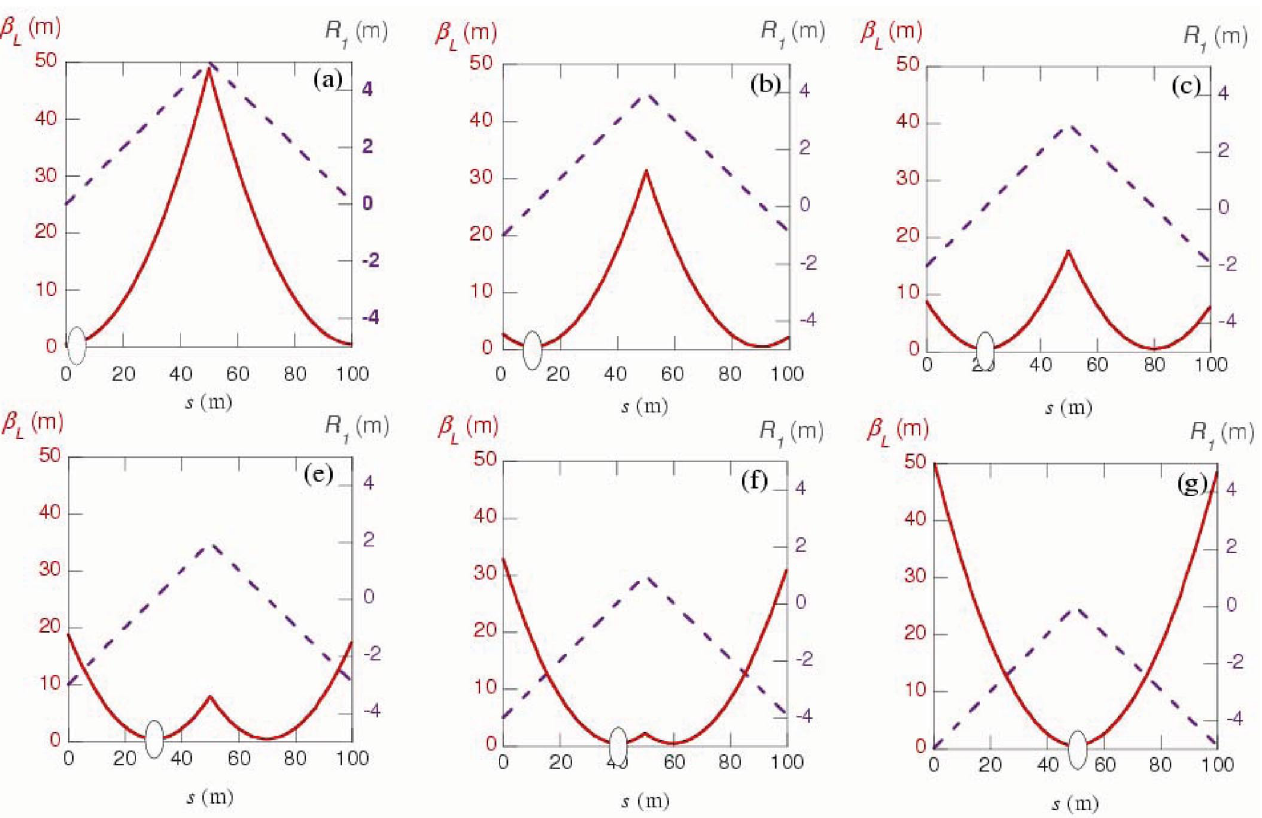
(cid:3) s (cid:4) (black dashed lines) along the ring for different positions of the cavity for a quasi 1 (cid:6) 7 : 5 MV rf